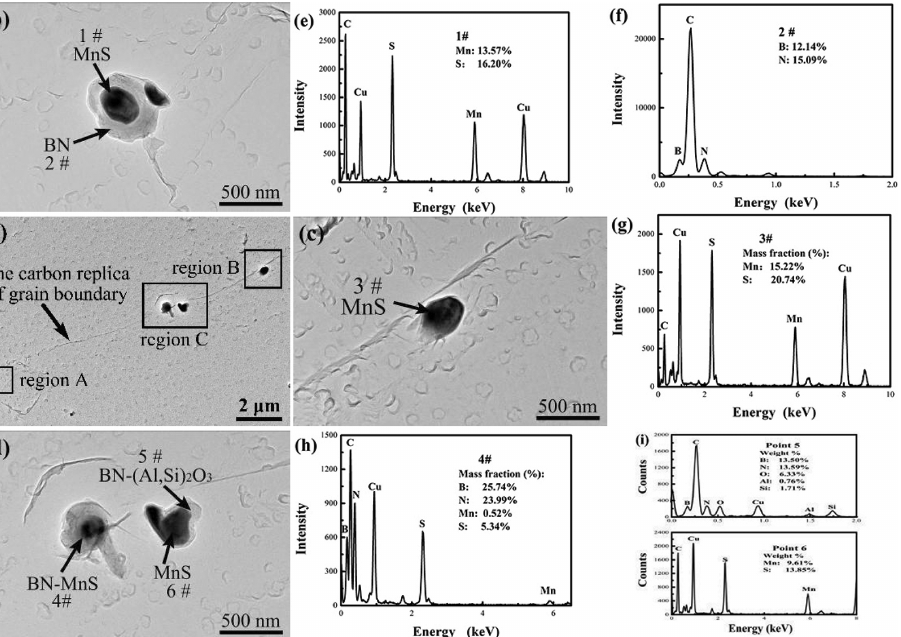
Figure 7: The characteristics of the grain boundaries and secondary phase particles obtained from the carbon replica of alloy B1 specimen tested at 900°C: (a) the low-magnification image of grain boundaries in the specimen; (b – d) the high-magnification images showing the secondary phase particles on grain boundaries in regions A, B and C, respectively; (e – i) the EDS spectrums of secondary phase particles denoted by 1 – 6#,